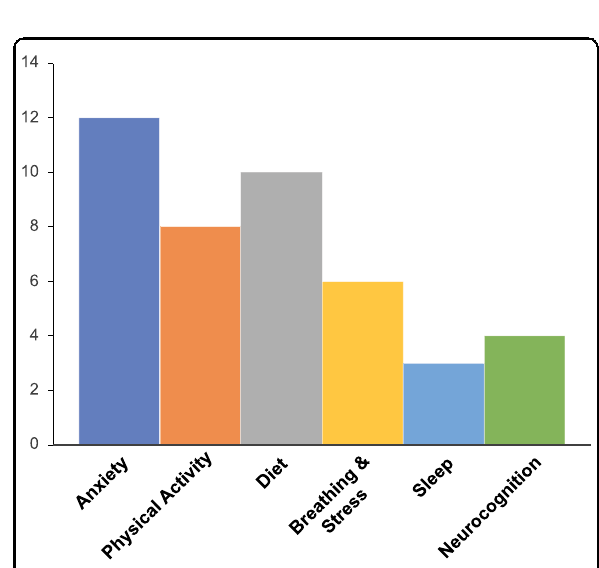
Fig. 5 Personalized ML informed top- fi ve ranking features across individuals. Frequency of top- fi ve ranking Shapley feature domains across participants cumulated based on the personalized ML models in individual subjects are